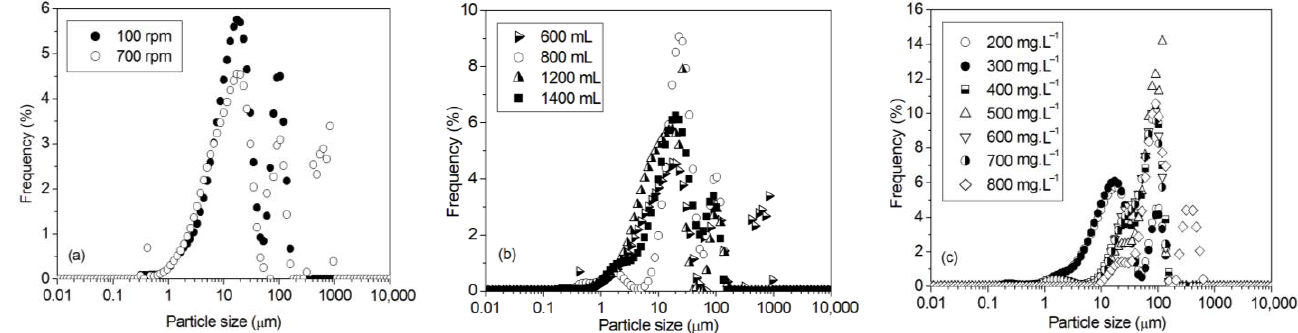
Figure 7. Particle size distributions of struvite crystals for ( a ) selected stirring rates at an initial phosphorus concentration of 200 mg·L −1 and a solution volume of 600 mL, ( b ) different solution volumes at a stirring rate of 700 rpm, and ( c ) different initial phosphorus concentrations at a stirring rate of 100 rpm and a solution volume of 600 mL.